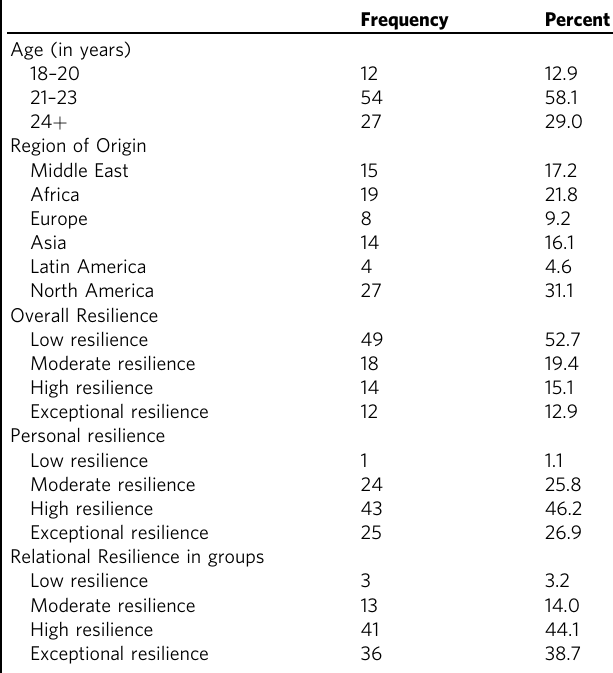
Table 1 Socio-demographic characteristics of participants – nominal variables ( N =